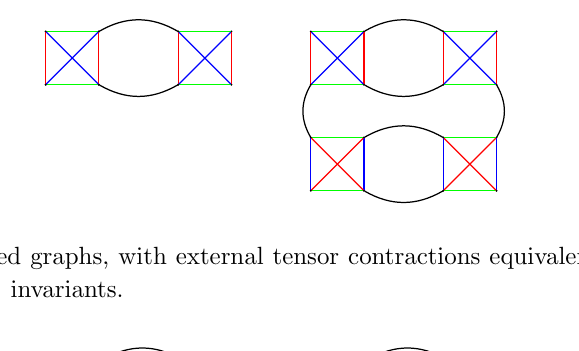
Figure 1 . Graphical representation of the quartic O ( N ) 3 invariants. From left to right: the tetrahedron, the pillow, and the double-trace (there are three pillow contractions, distinguished by the color of the vertical edge).